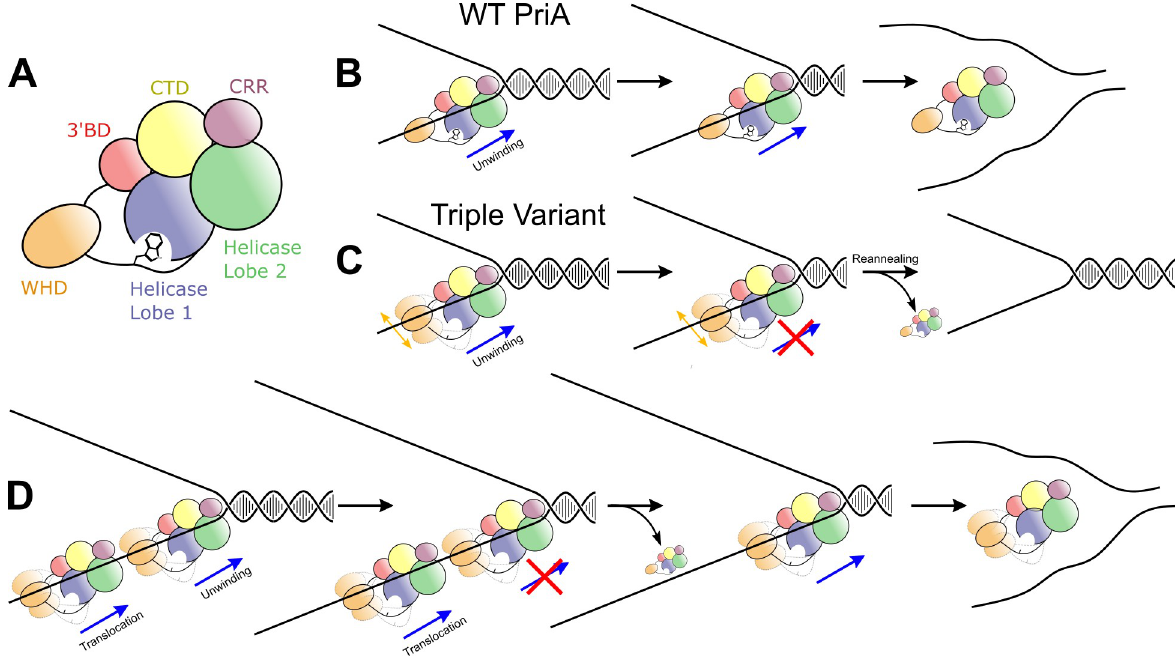
Fig 6. PriA linker variants may be less processive, requiring multiple molecules to unwind forks. (A) Cartoon of PriA domain layout colored as in Fig 1A. (B) Model depicting one molecule of wild-type PriA unwinding long tracts of dsDNA. (C) PriA linker variants are less processive than wild-type PriA. One molecule is insufficient to unwind long tracts of DNA. (D) Multiple aligned linker variant PriA molecules can unwind long dsDNA tracts. If one molecule partially unwinds the duplex but falls off, other molecules can replace it.